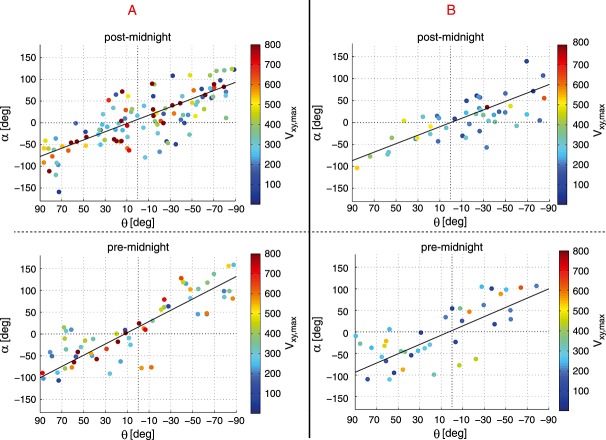
Direction and value of the maximum ion velocity in XY plane after Bz,min in the premidnight and postmidnight sector for (left column) category A and (right column) category B; α is the angle between the maximum plasma velocity Vxy,max and nxy,T89, and θ denotes the angle between nxy,T89 and XT89. The black line represents the least squares fit of the SSOs.